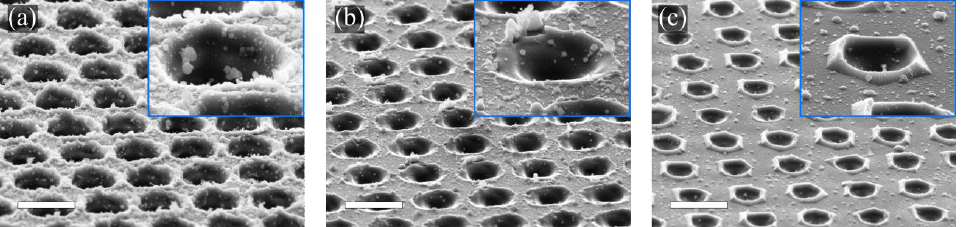
Figure 4. Optical image of the GaSe surface with ARMs , inscribed at Е = 37.5 nJ and numbers of pulses N = 1, 3, 5, and 8 on both sides of the sample. Figure 5. SEM image of GaSe surface with ARMs, inscribed at E = 37.5 nJ and numbers of pulses: 8 ( a ), 3 ( b ), and 1 ( c ). Scale bar—3 µ m. One of the craters is shown separately in the upper right corner of each image.